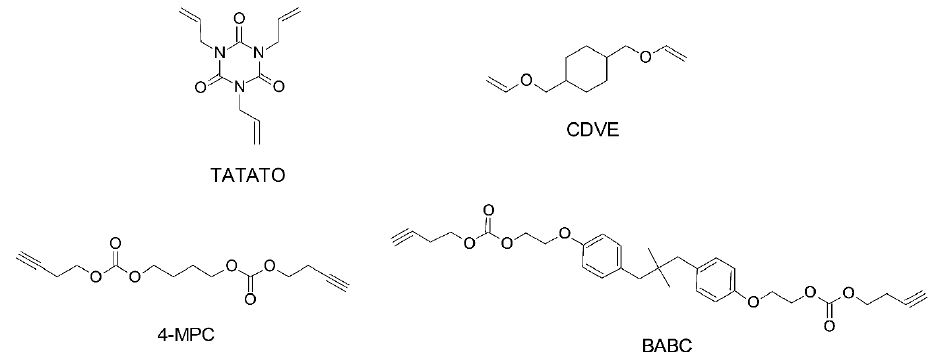
Figure 22. Structure of selected alkenes and alkynes used for vat photopolymerization 3D printing.